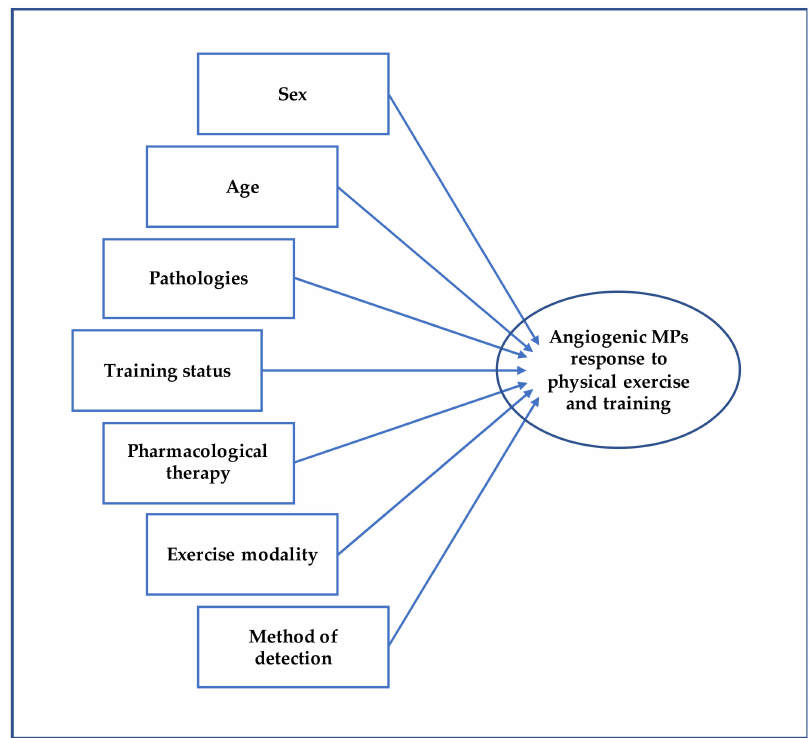
Figure 3. This figure shows the potential influencing factors a ff ecting MPs following physical exercise and